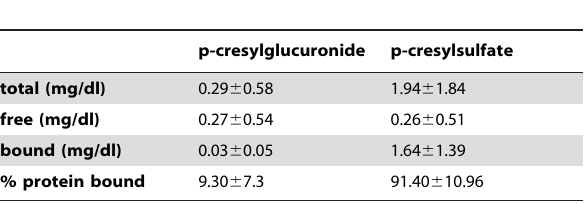
Table 3. Serum concentrations of p-cresylglucuronide and p- cresylsulfate (total, free and bound) in the study